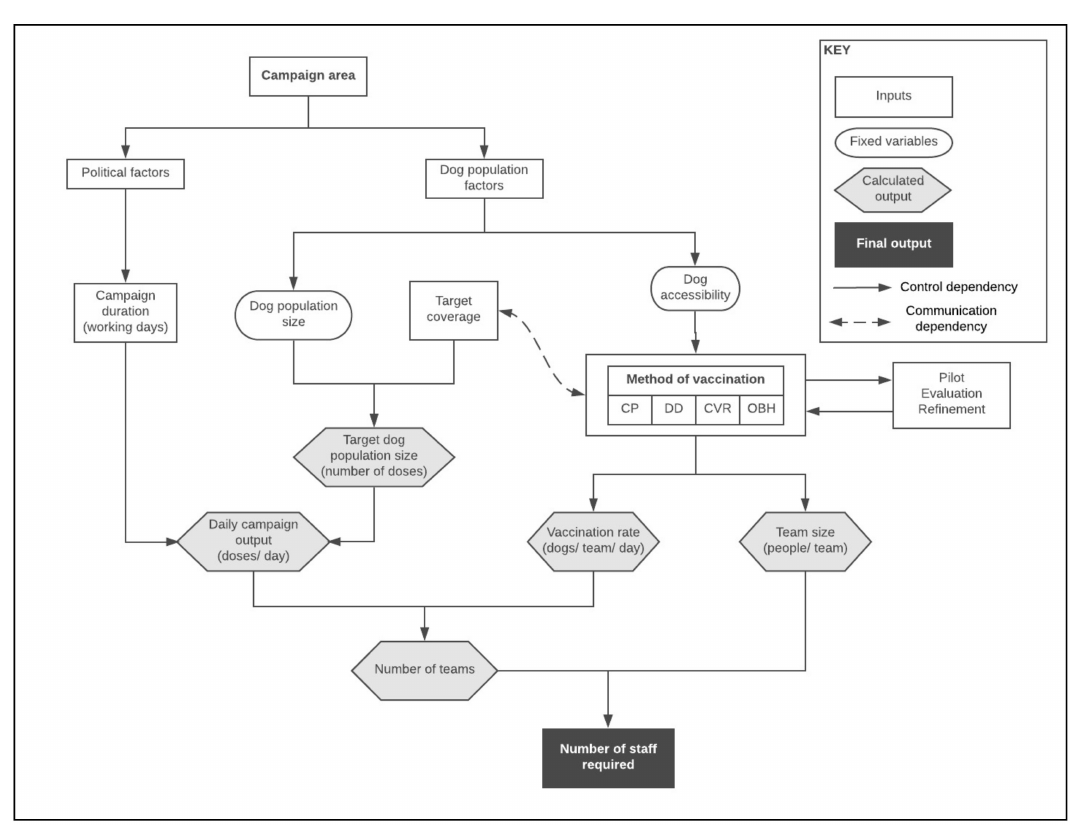
Figure 1. Dependency graph showing the interwoven dependencies involved in vaccination campaign